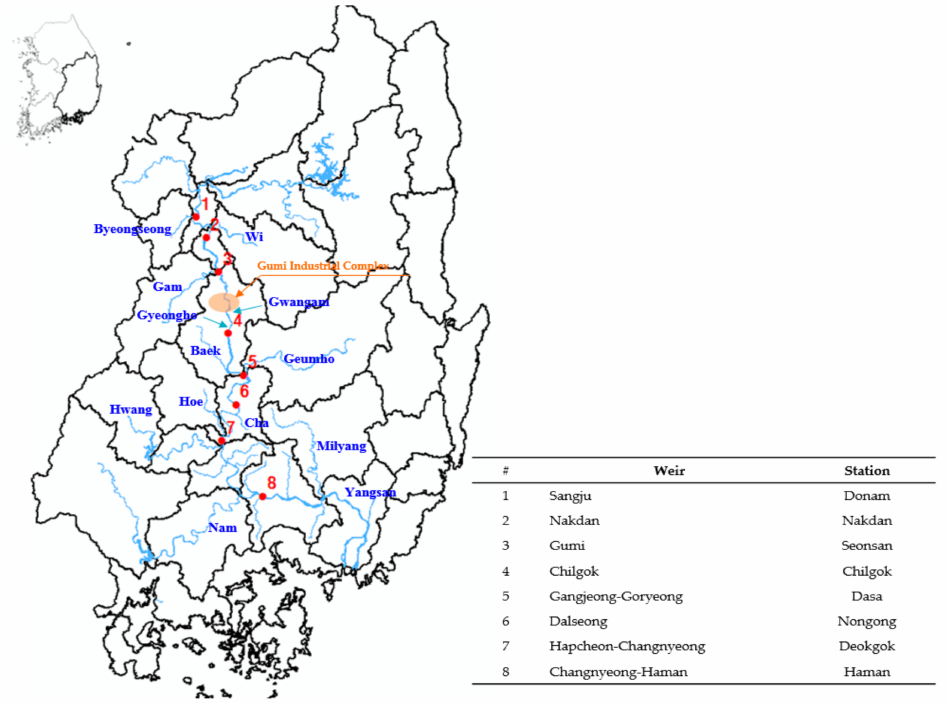
Figure 1. Location of weirs in the Nakdong River